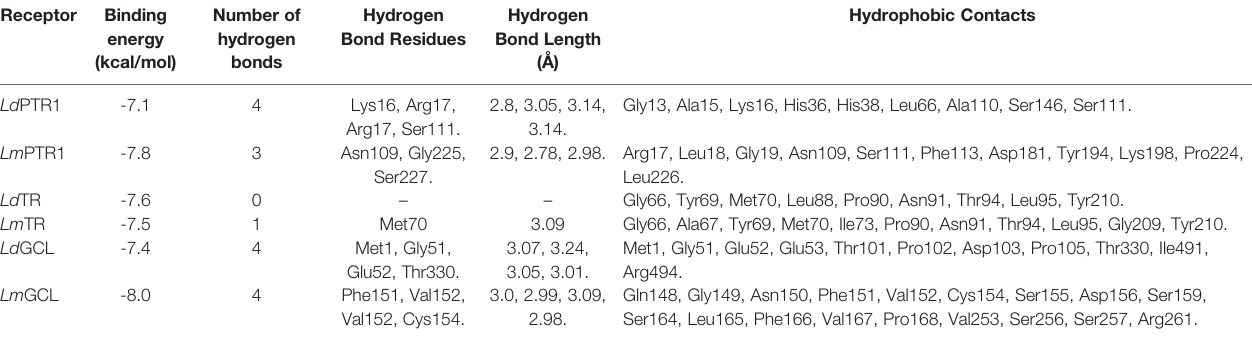
TABLE 3 | Binding af fi nities and protein-ligand interactions of HA docked with the six receptors, namely Ld PTR1, Lm PTR1, Ld TR, Lm TR, Ld GCL, and Lm GCL. Receptor Binding